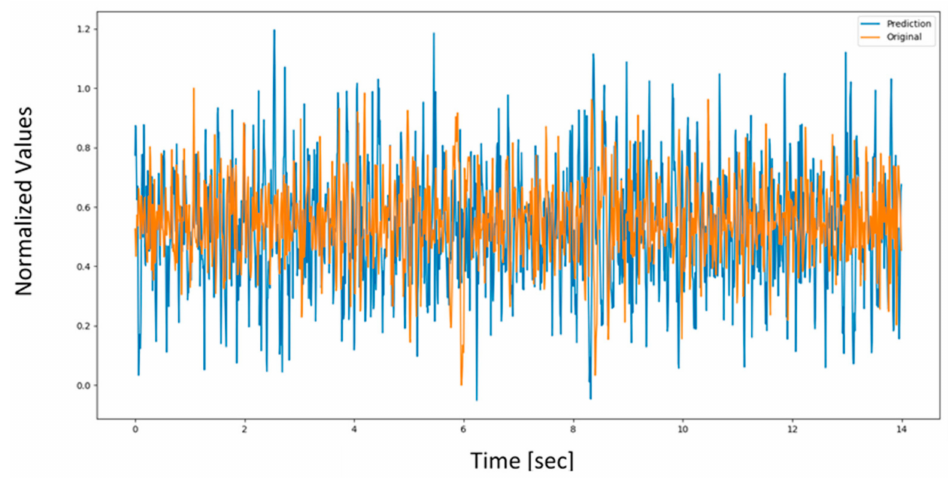
Figure 30. Channel 2 prediction based on the three FBG inputs for the LSTM model.